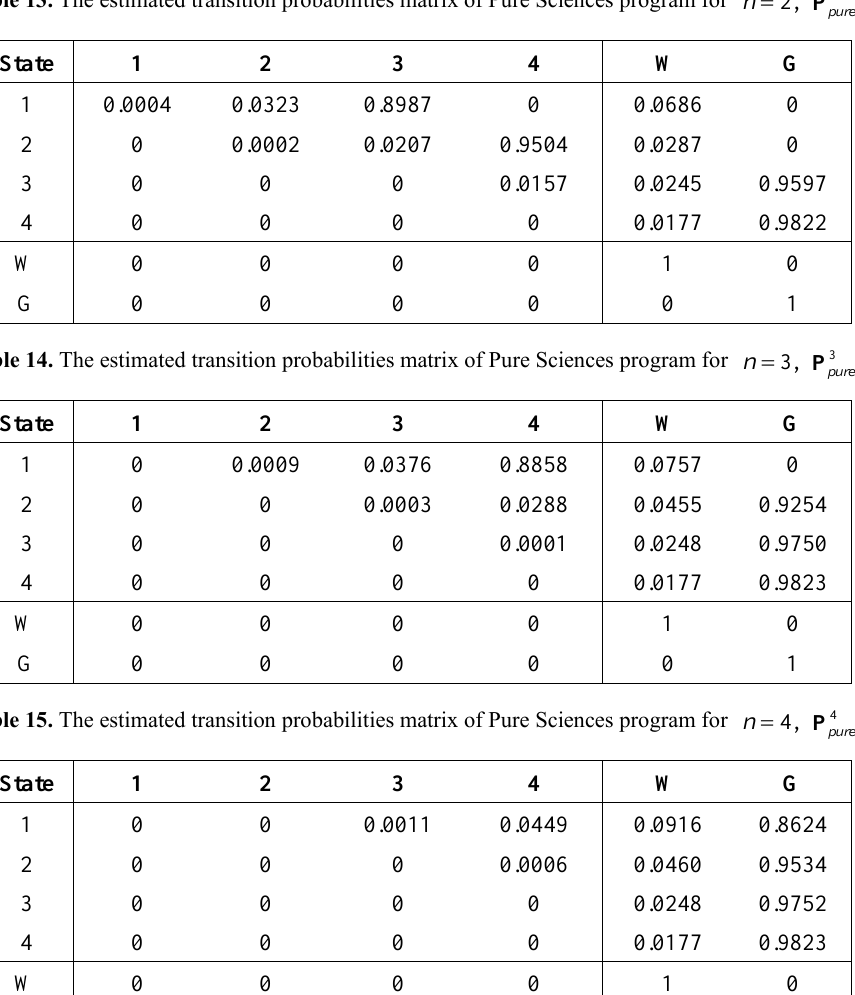
Table 13. The estimated transition probabilities matrix of Pure Sciences program for , 2 = n 2